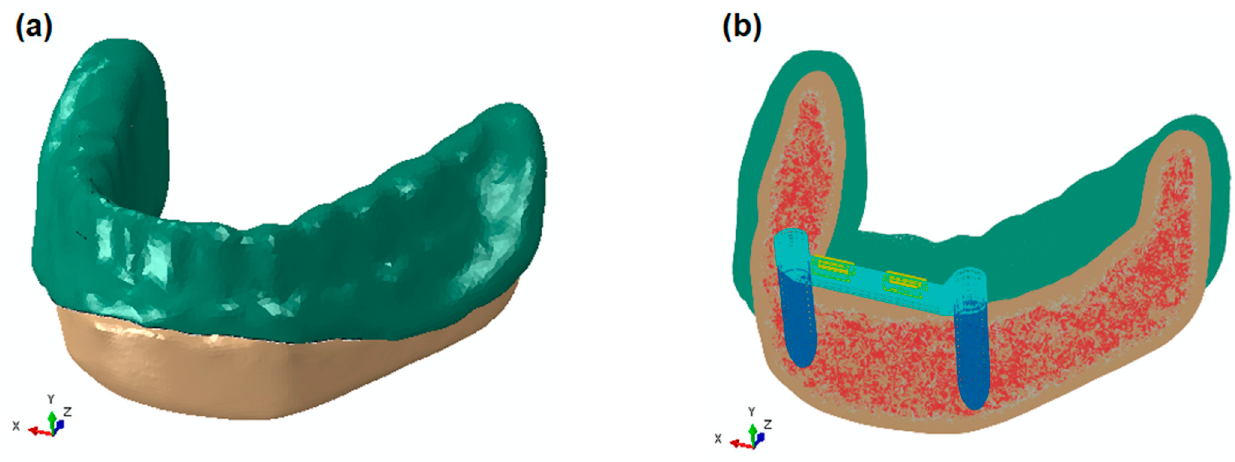
Figure 2. Numerical geometry of the system: ( a ) 3D view and ( b ) transparent 3D view.